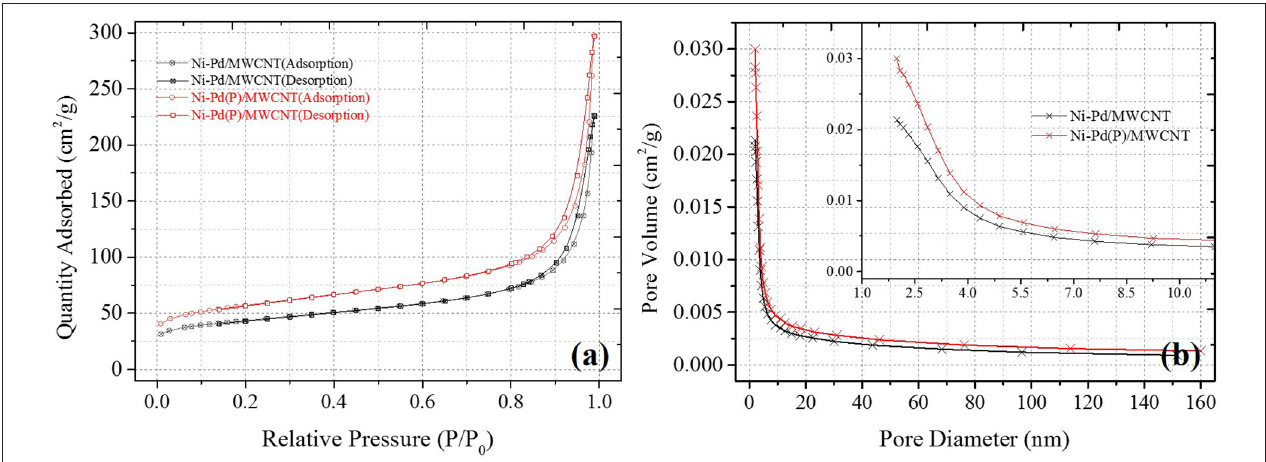
FIGURE 10 | BET analysis results of Ni-Pd/MWCNT and Ni-Pd(P)/MWCNT: (A) Adsorption isotherms and (B) pore volume plots obtained after equilibrating for 10s in